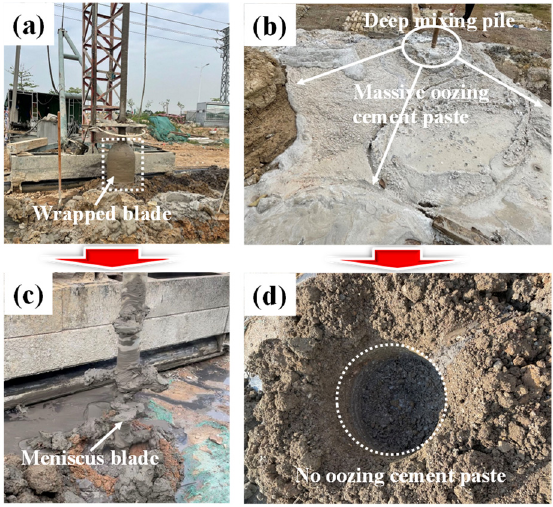
Figure 3. Influence of different types of blades on the construction process: ( a , b ) strip blade and ( c , d ) meniscus blade.